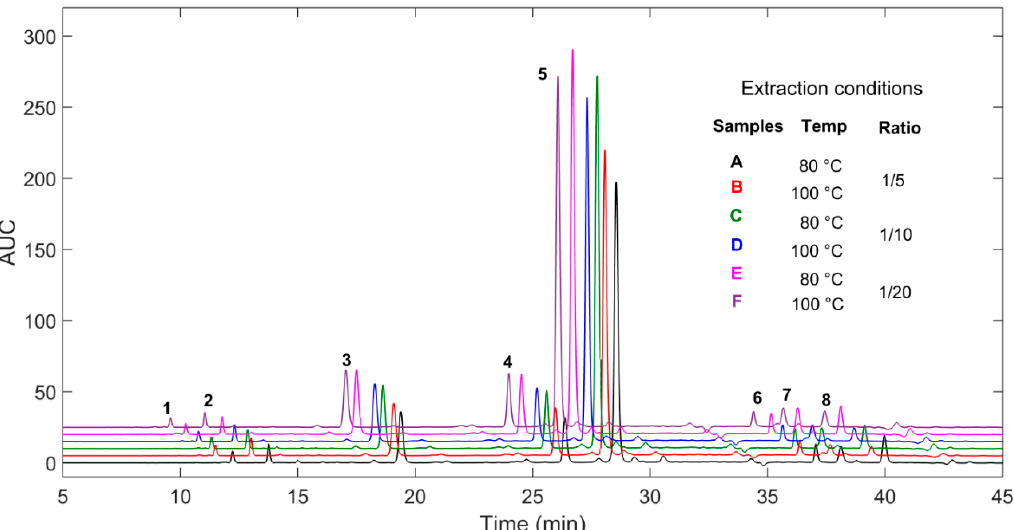
Figure 1. Superposed chromatogram profiles of some of the 36 extracts.